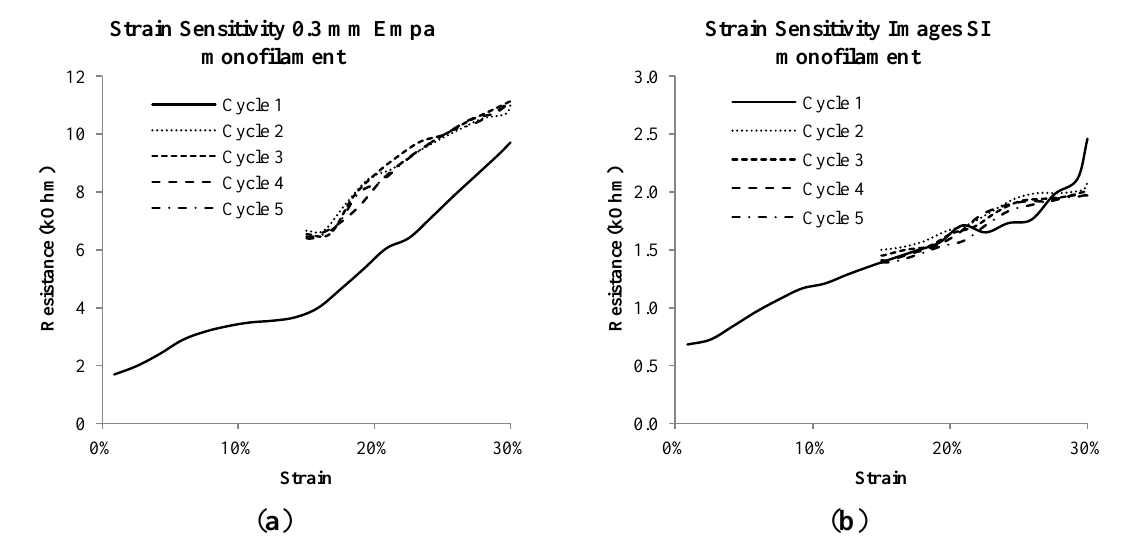
Figure 9. ( a ) Successive loadings of the cycle testing of the Empa 0.3 mm and ( b ) Images SI